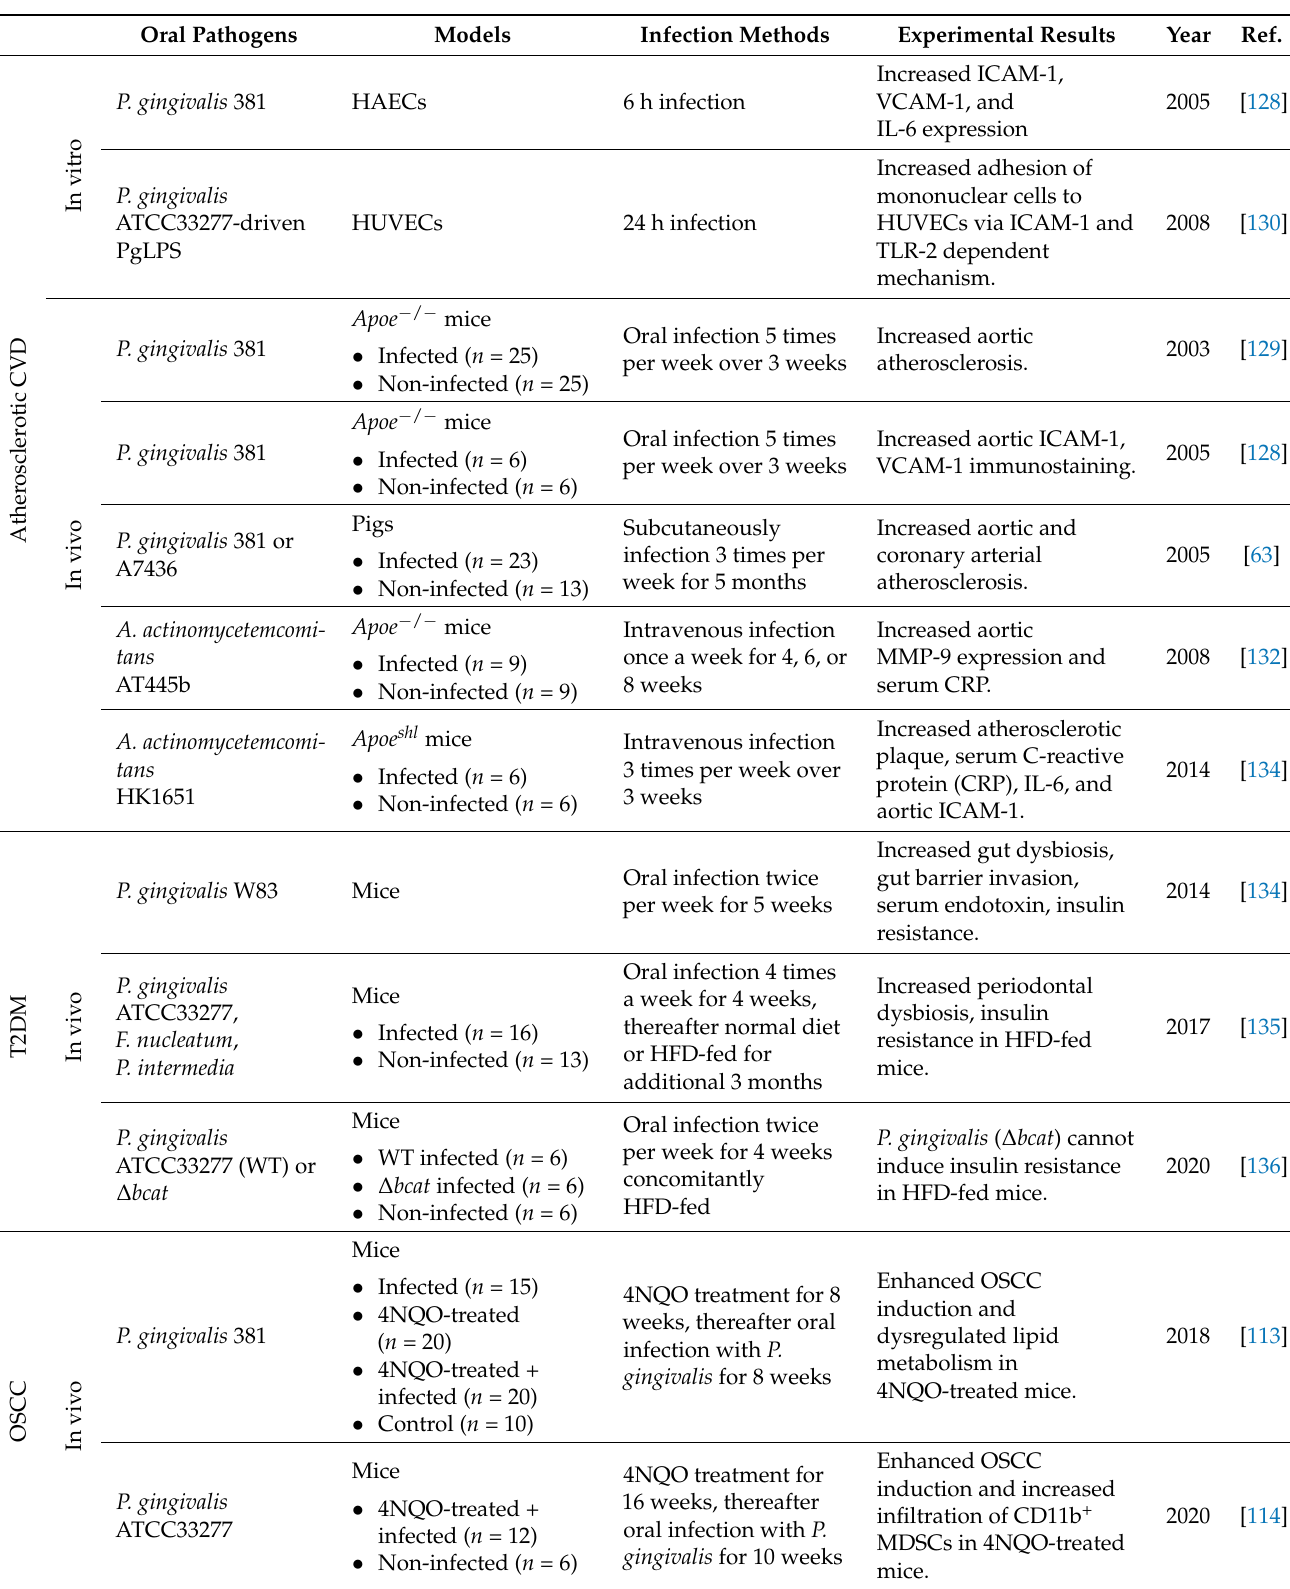
Table 2. The systemic disease models induced by oral